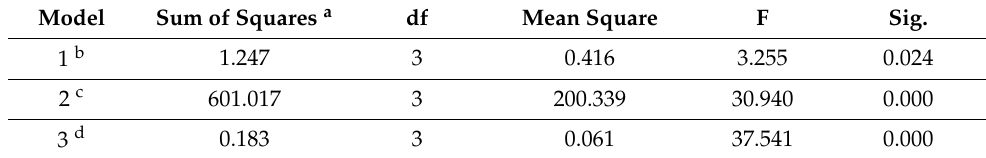
Table 10. Absolute values of residuals and banks’ performance model (ANOVA).